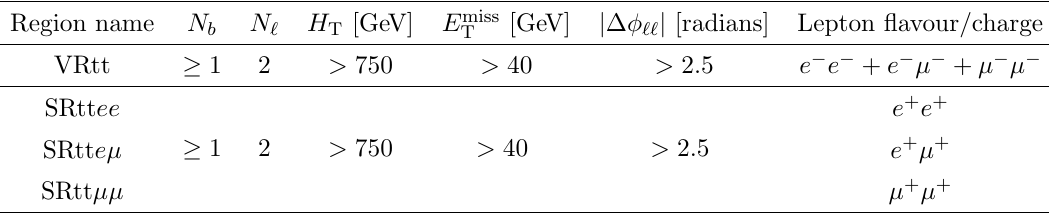
Table 4 . De(cid:12)nitions of the validation and signal regions for the same-sign top-quark pair production search, where N b is the number of b -tagged jets, N ‘ is the number of leptons, and azimuthal angle between the leptons. The name of each signal (validation) region begins with \SR" (\VR"). The validation region is inclusive in lepton